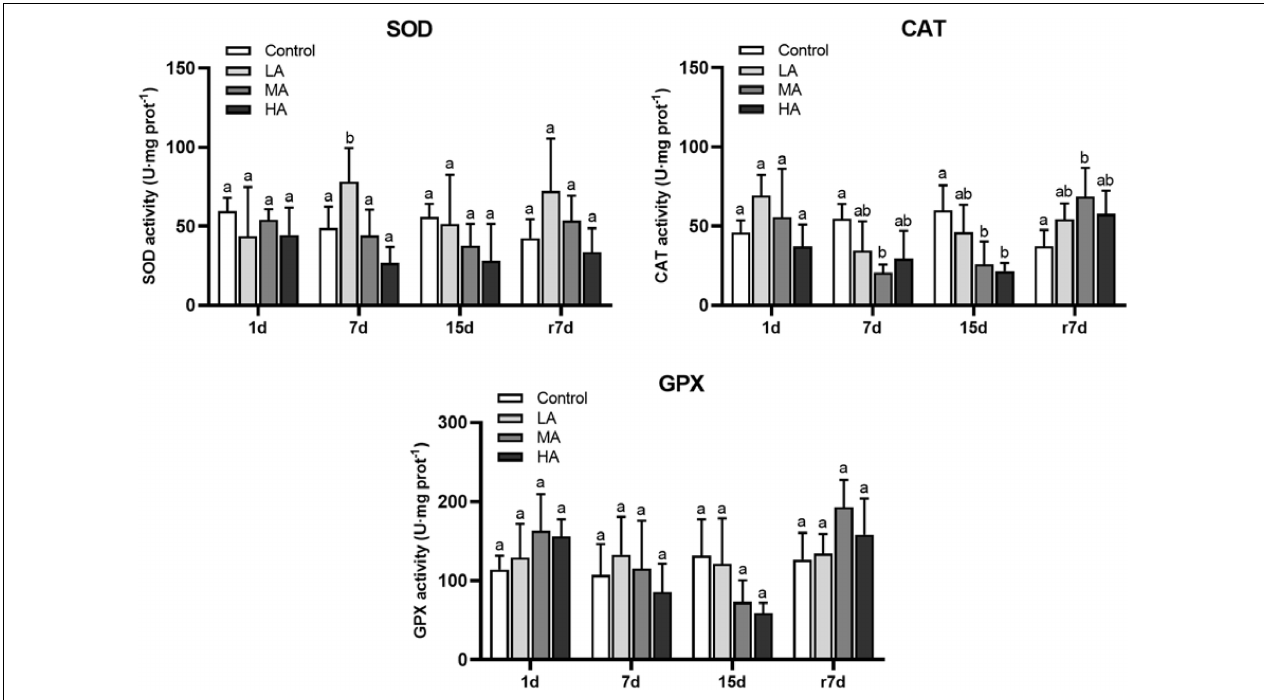
FIGURE 2 | The enzymes activities in hepatopancreas of P. trituberculatus after ammonia stress and recovery. Data are represented as mean ± S.D., n = 4-6, with P < 0.05 considered significant. Different letters represent significant differences among different groups.